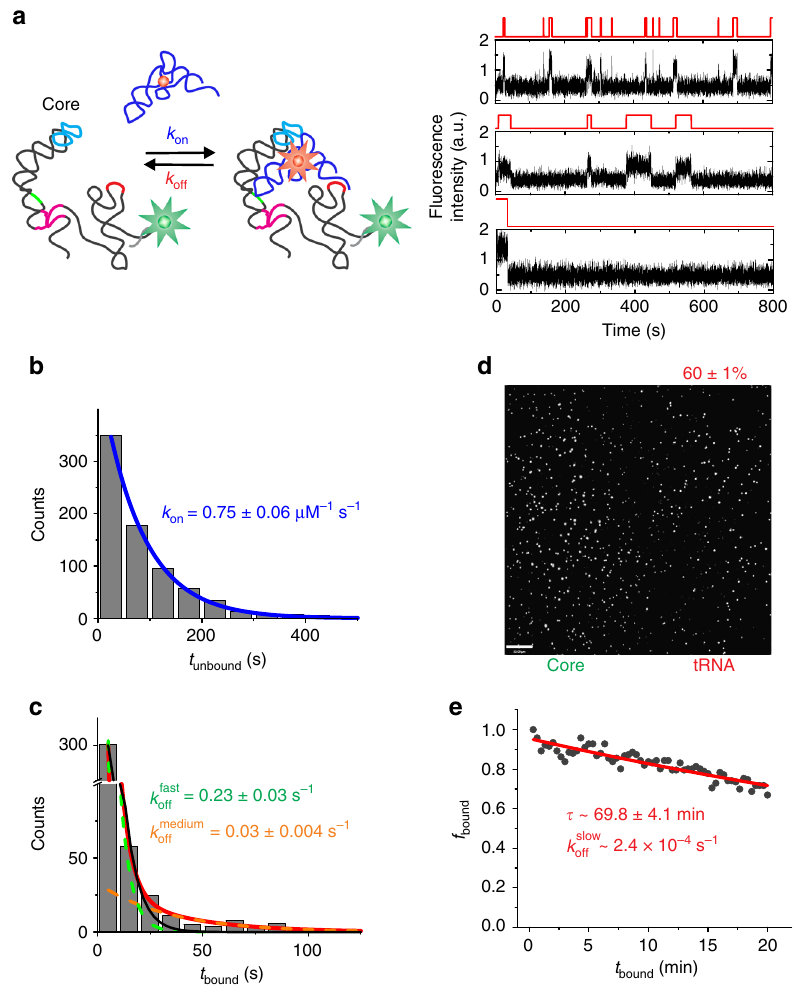
Fig. 4 Kinetic analysis of tRNA binding to core T-box riboswitch. a Schematic and representative traces of tRNA binding to the core T-box riboswitch at 10 mM Mg 2 + showing static heterogeneity between different traces. b Dwell-time distribution of t unbound fi t with a single-exponential function (blue). c Dwell- time distribution of t bound fi t with a double-exponential function (red), deconvolved into the k fast fi t with a single-exponential function is shown as a black curve. d Average image of fi rst 30 frames (3 s) for uncharged tRNA binding to the core riboswitch. The spots in the Cy5 channel correspond to tRNA molecules in the ultra-stable complexes that remained associated with core T-box ~10 min after immobilization to the slide. e Fraction of the surface-bound tRNA molecules co-localized with the core T-box riboswitch, f bound , as a function of time. The data are fi t with a single-exponential function to determine the tRNA bound lifetime of the ultra-stable complexes. Errors are s.d. of three independent